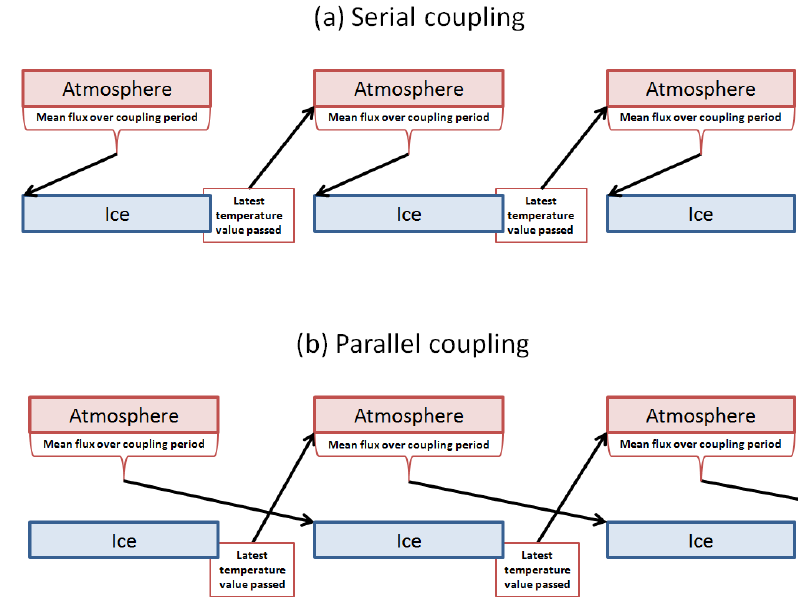
Figure 7. Schematic demonstrating the (a) serial and (b) parallel coupling frameworks, as described in Sect.